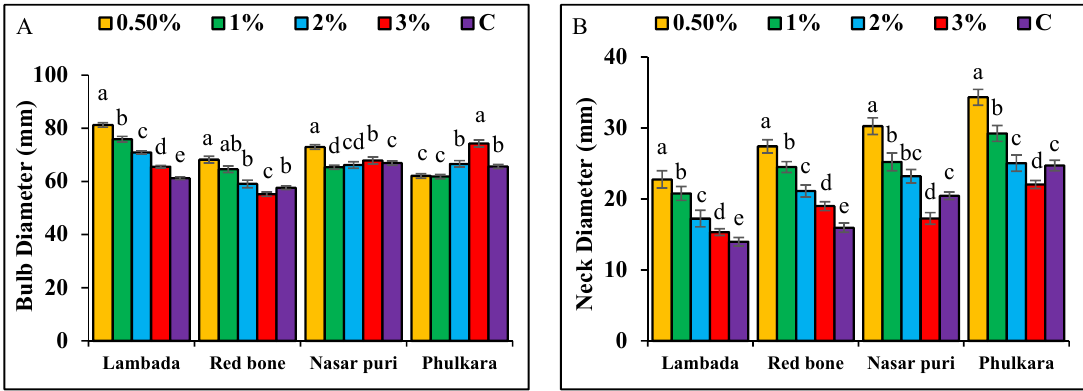
Figure 4. Bulb diameter ( A ) and neck diameter ( B ) in onion cultivars as affected by foliar application of 0 (C = control), 0.5, 1, 2, or 3% seaweed extract. Values are means of nine replicates ± standard error. Means with different letters are significantly different from each other compared by LSD at p ≤ 0.05.